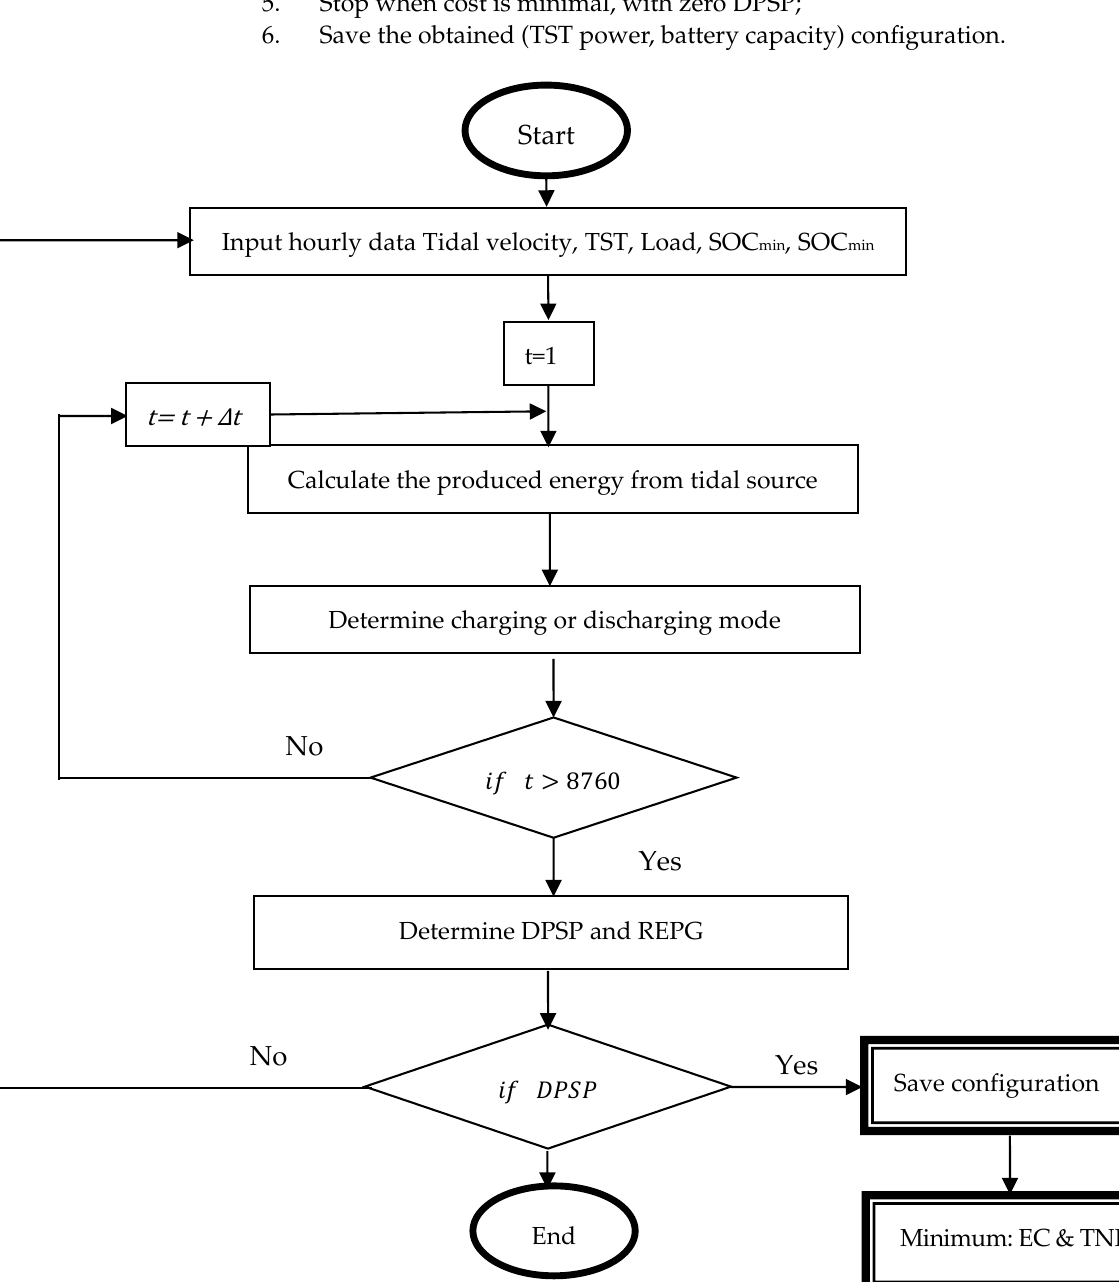
Figure 4. Optimal sizing algorithm flow chart.